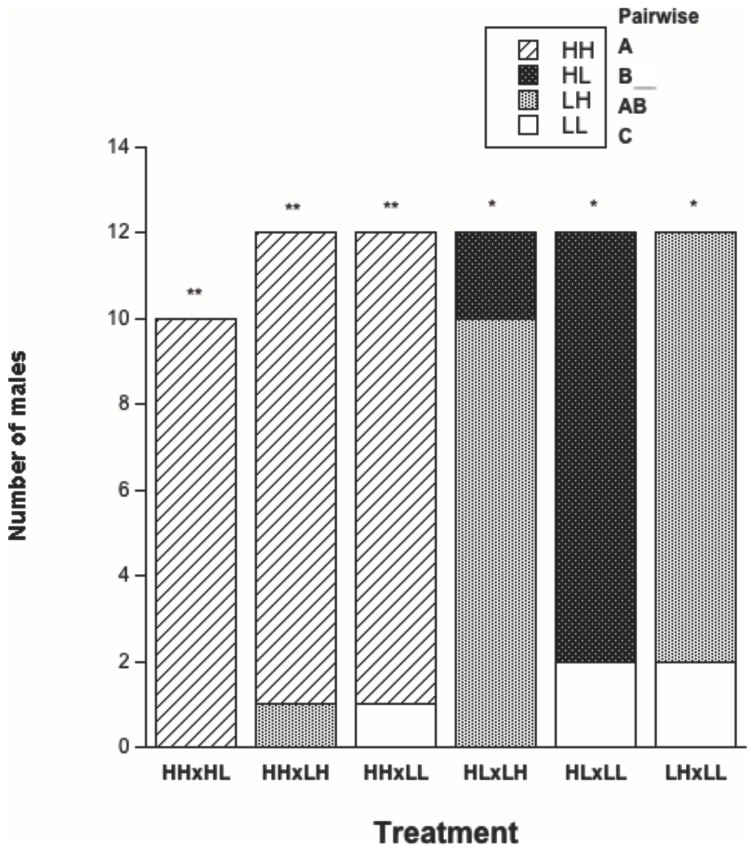
Feeding treatment and female attractiveness.There was a significant difference (p < 0.05*, p < 0.01**) in attractiveness between the four groups (HH = 32, HL = 12, LH = 21, LL = 5), with the results of pairwise analyses depicted by letters (A, B, C) in the top right of the graph.